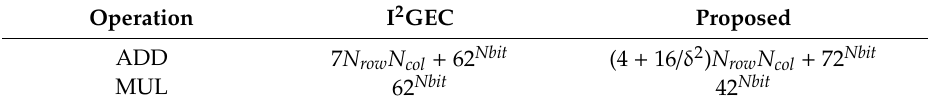
Table 3. Average and minimum computation times for the proposed and benchmark methods.